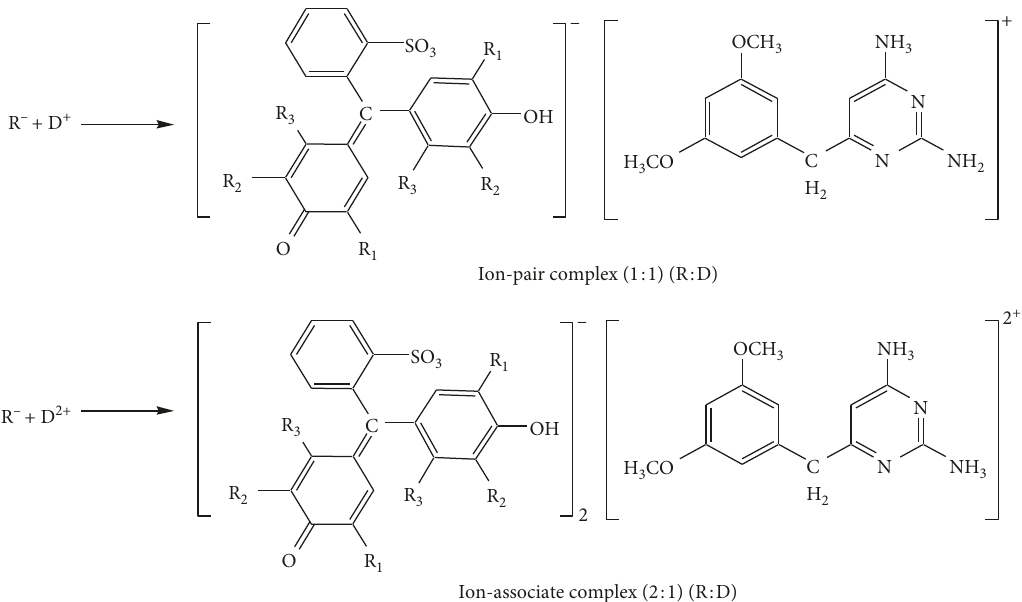
Scheme 3: The reaction mechanisms of the formation of ion-pair and ion-associate complexes.